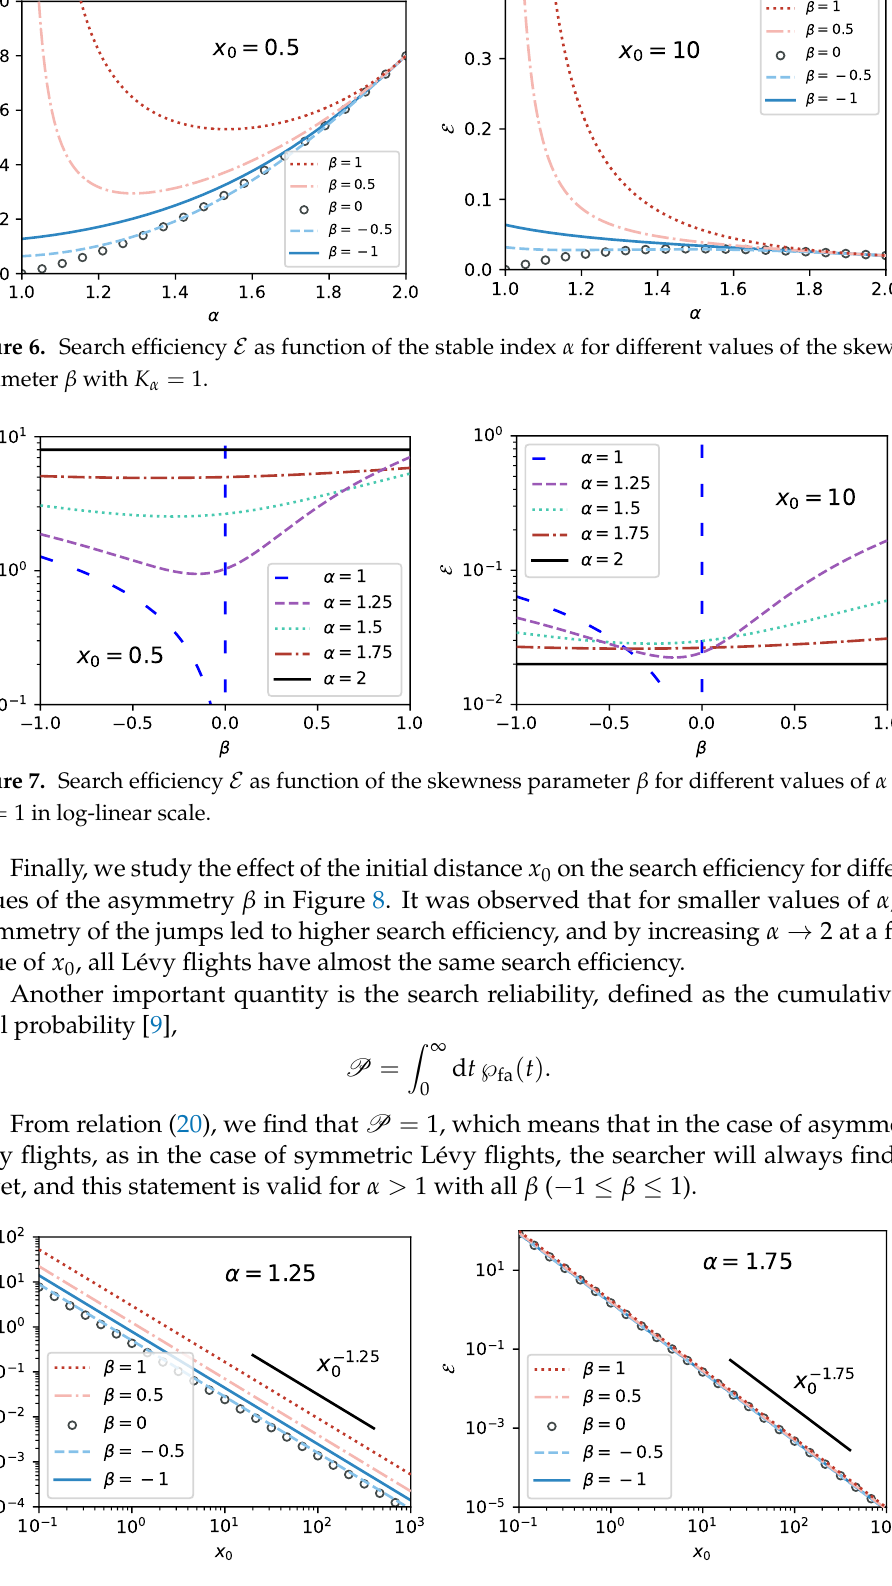
Figure 8. Search efficiency E as function of the initial position x 0 for different β with K α = 1 on log-log scale. The short solid line shows the asymptote x − α